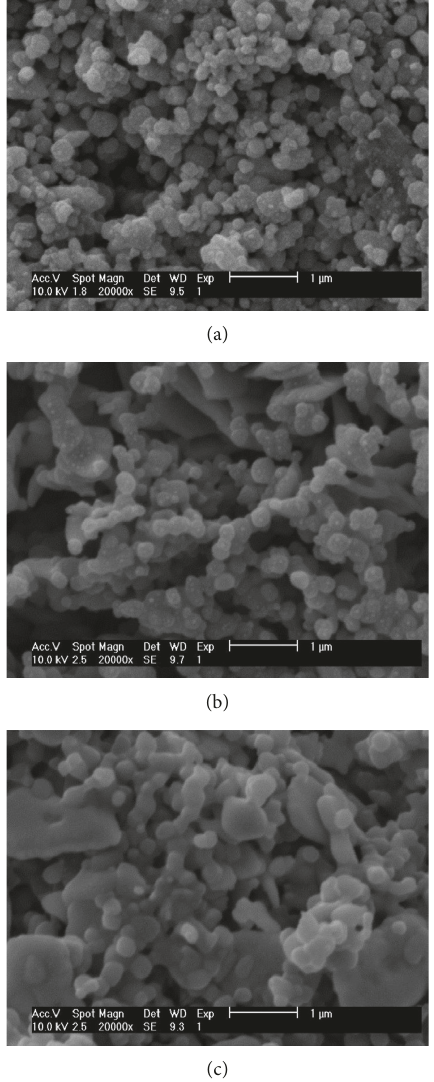
Figure 1: SEM micrographs of the TiO 2% (a), 4% (b), and 6% (c) content of Nb